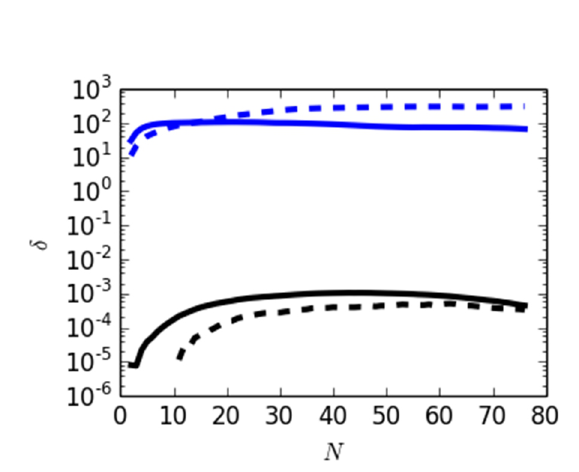
Figure 8. Displacement δ (in cm) from the straight trajectory estimate as a function of N semi-global correction iterations. The displacement of the top (bottom) end of the trajectory is shown with black (blue) lines. Dashed (solid) lines represent absolute displacements in the x (y) -direction. Note the logarithmic scale. Displacements converge after some N=40 iterations.